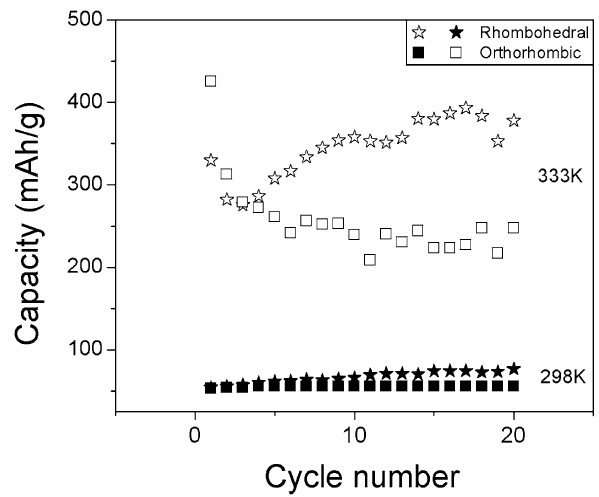
Fig. 3 Plot of the discharge capacity as a function of the cycle number in a La 1 - x Sr x FeO 3 ( x = 0.2: orthorhombic structure, x = 0.4: rhombohedral structure). Data adapted from